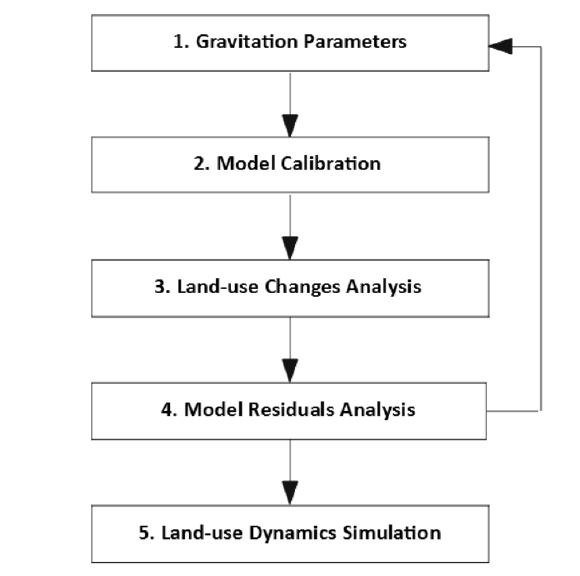
Figure 5. Proposed methodology to analyze land-use dynamics using spatial interaction